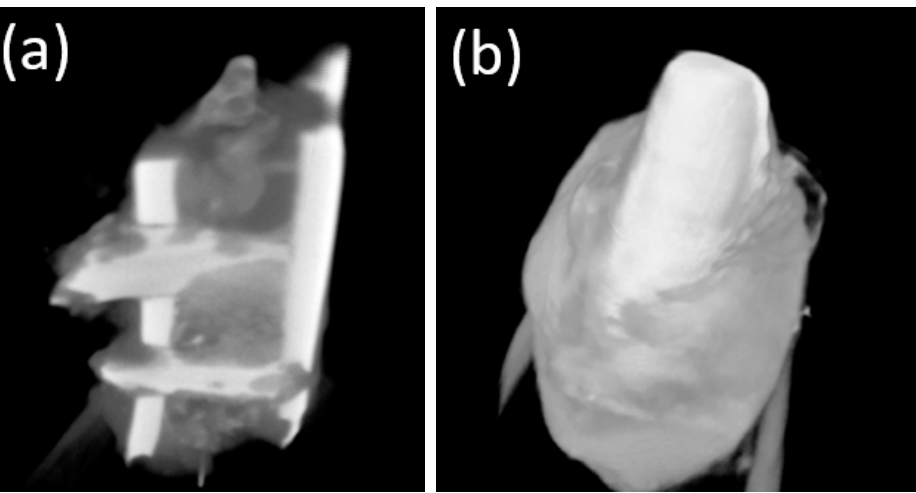
Figure 11. ( a,b ) Image of a fragment of the femur of an animal and the implant 1 month after implantation (obtained using micro-CT).